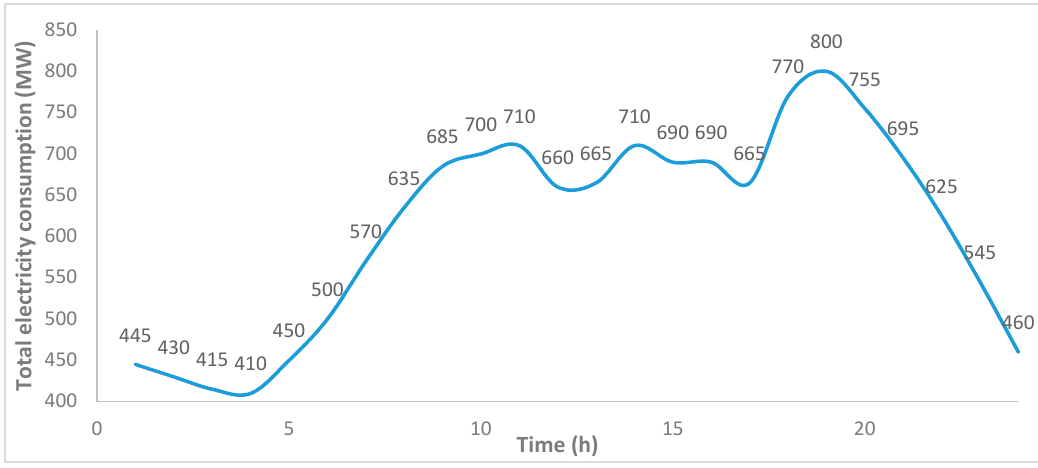
Figure 4. Total power consumption within 24 h operations.